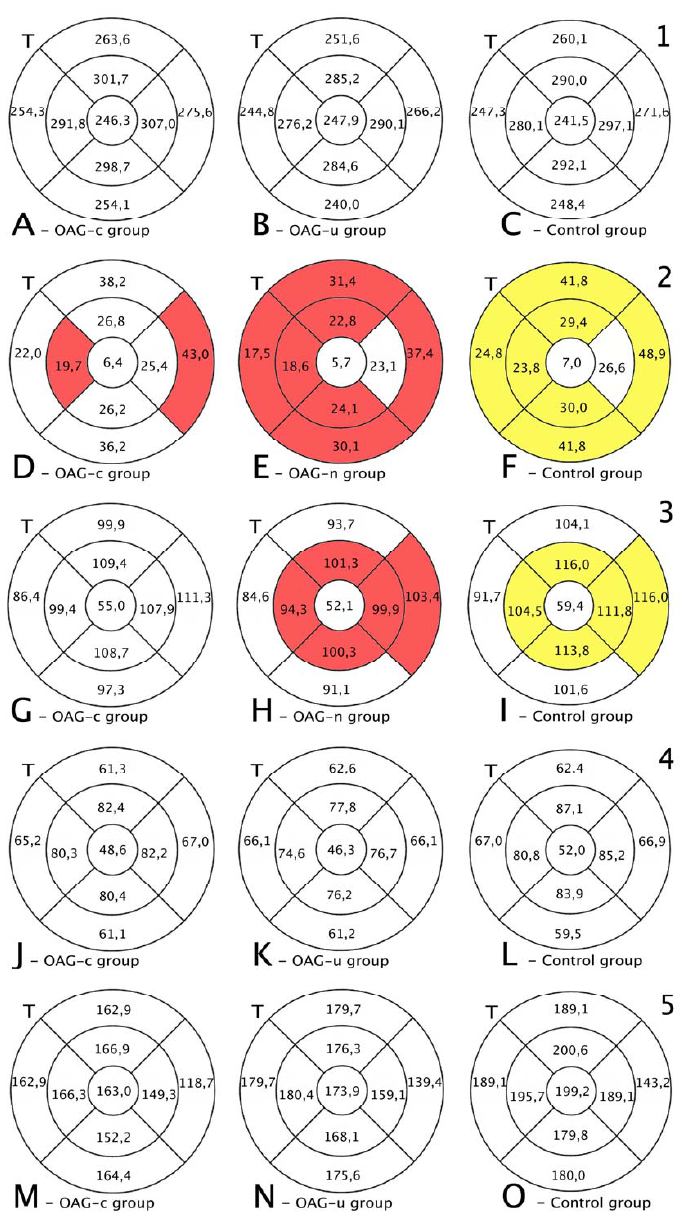
Figure 8. Comparison of posterior segment OCT results in ETDRS–9 subsegments and retinal layers 6 months after the cataract surgery between control and OAG c or OAG u groups. ( A – C ) total macular thickness, ( D – F ) RNFL thickness, ( G – I ) GCL++ thickness, ( J – L ) GCL+ thickness, ( M – O ) choroid thickness. Temporal side (T) is shown on the left. Mean layer thickness is shown in ETDRS–9 subsegments. Colours mark statistically significant differences: yellow—statistically significantly higher mean thickness, red—statistically significantly lower mean thickness ean, white—statistically significant difference not